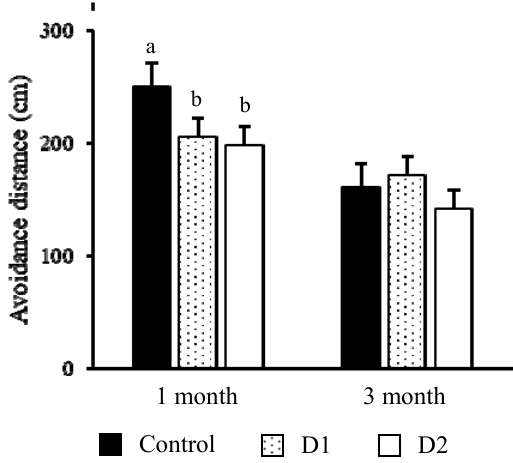
Figure 3. The comparison of the avoidance distance to the approaching trainer among the control calves (control, closed bar), calves stroked once a day (D1, dotted bar), and calves stroked twice a day (D2, open bar) in each test month. a,b Represents a significant difference among treatments within the month (p<0.05).